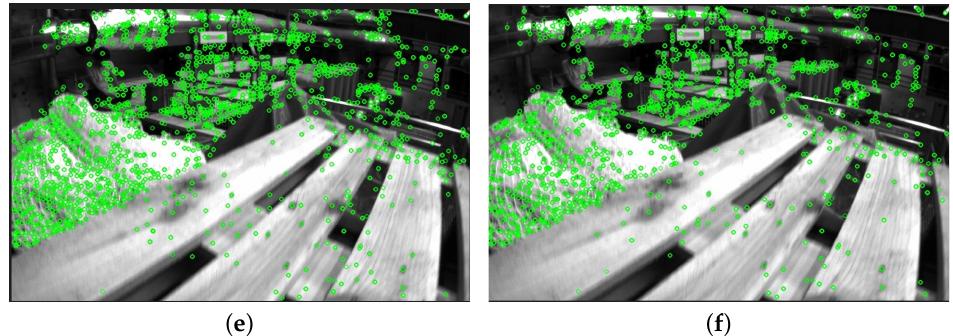
Figure 8. The extraction result of feature points of the 11th reference image. ( a ) Feature point extraction result of the SIFT algorithm; ( b ) feature point extraction result of this algorithm.